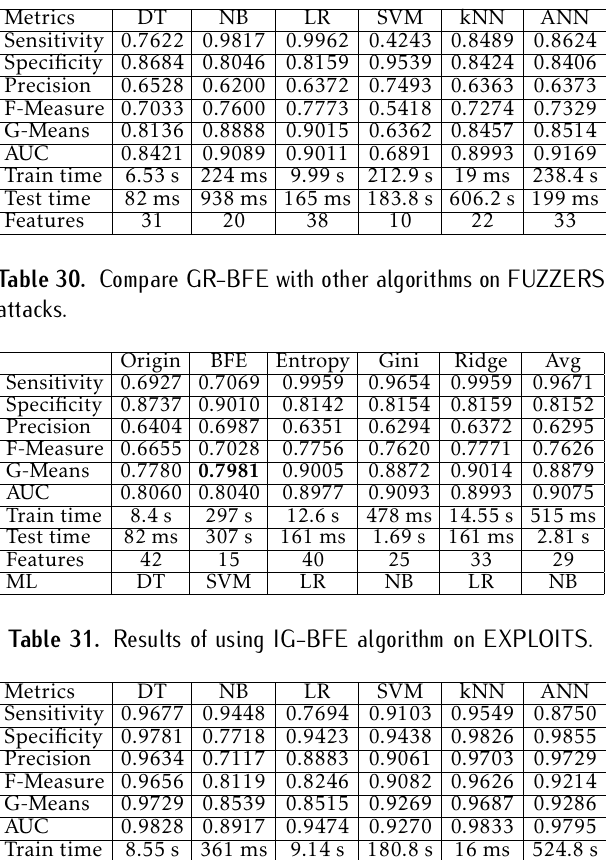
Table 25. Results of using CA-BFE algorithm on DOS.